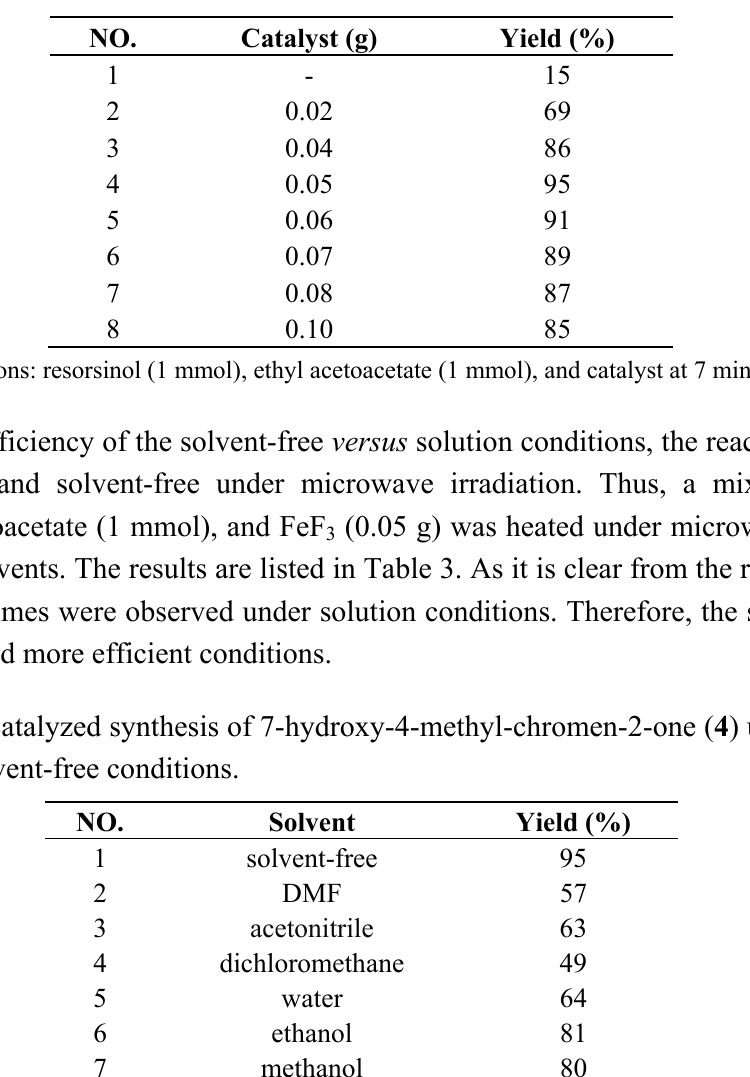
catalyzed synthesis of 7-hydroxy-4-methyl-chromen-2-one ( 4 ) in various Table 2. FeF 3 amount of the catalyst under solvent-free microwave irradiation a .